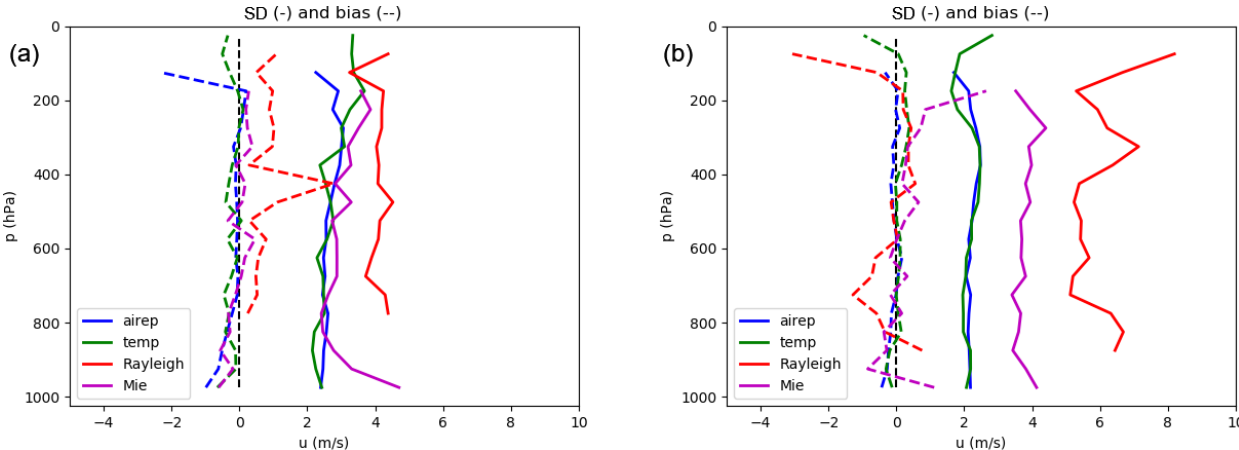
Figure 2. The standard deviation and bias of the observation minus background (O − B) for the laser A (a) and laser B (b) periods of Aeolus HLOS data (Rayleigh in red lines and Mie in magenta lines) against aircraft (blue lines) and radiosonde data (green